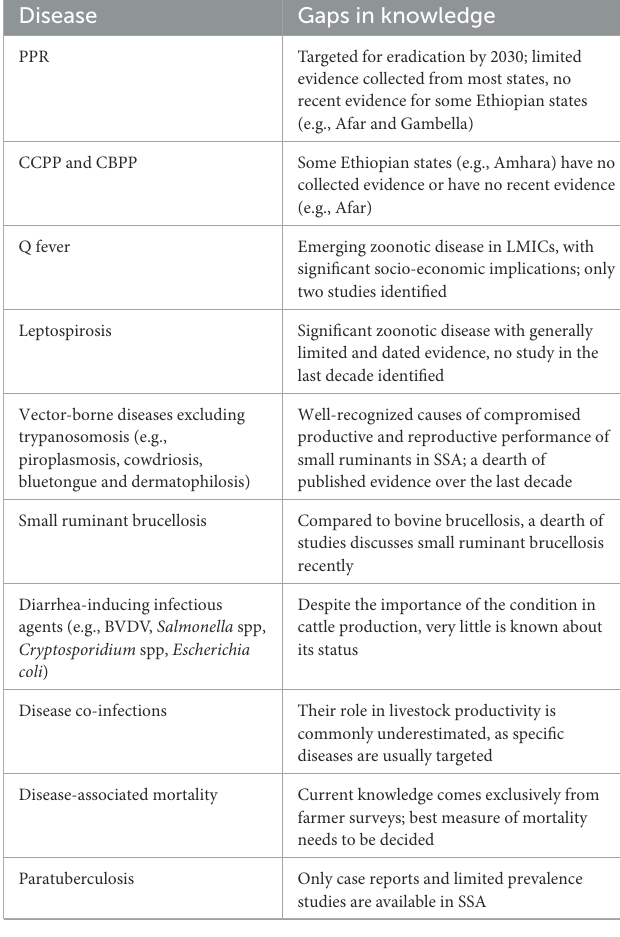
TABLE 1 Gaps in knowledge of certain